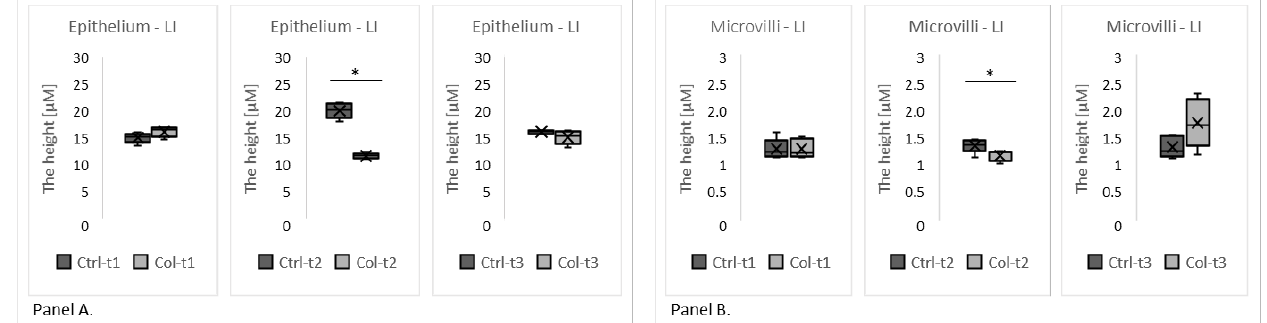
Figure 5. The charts show the height of the epithelium ( Panel A ) and microvilli ( Panel B ) in the large intestine of rabbits treated with Col for 1, 3, or 6 months matched with the appropriate time point control. * p (two-tailed) ≤